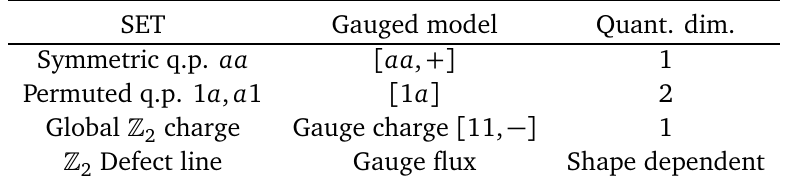
Table 1: The effect of gauging a (cid:90) symmetry that acts via swapping layers in 3D on 2 a generating set of particles. The pointlike quasi-particles (q.p.) in the first two rows may include fractons, lineons, planons, or have no mobility